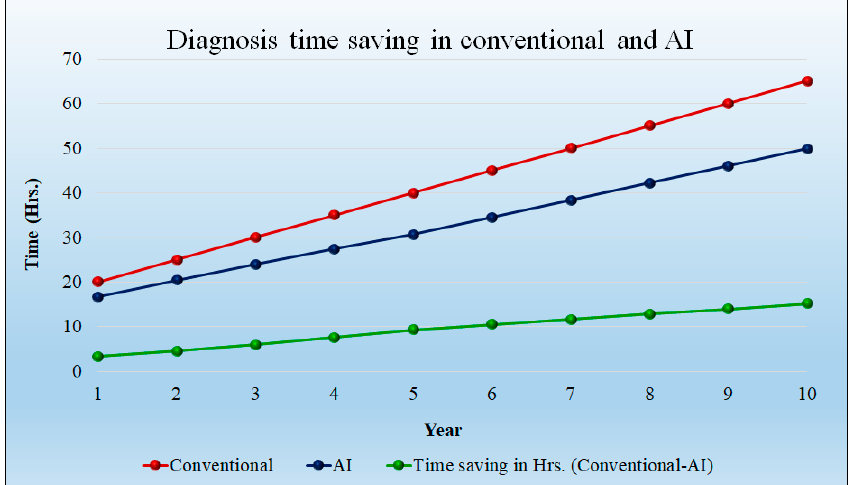
Figure 11. Time ‐ saving for AI ‐ based diagnosis model (green). Conventional model (red) vs. AI (blue) showing year vs. time (in hours).